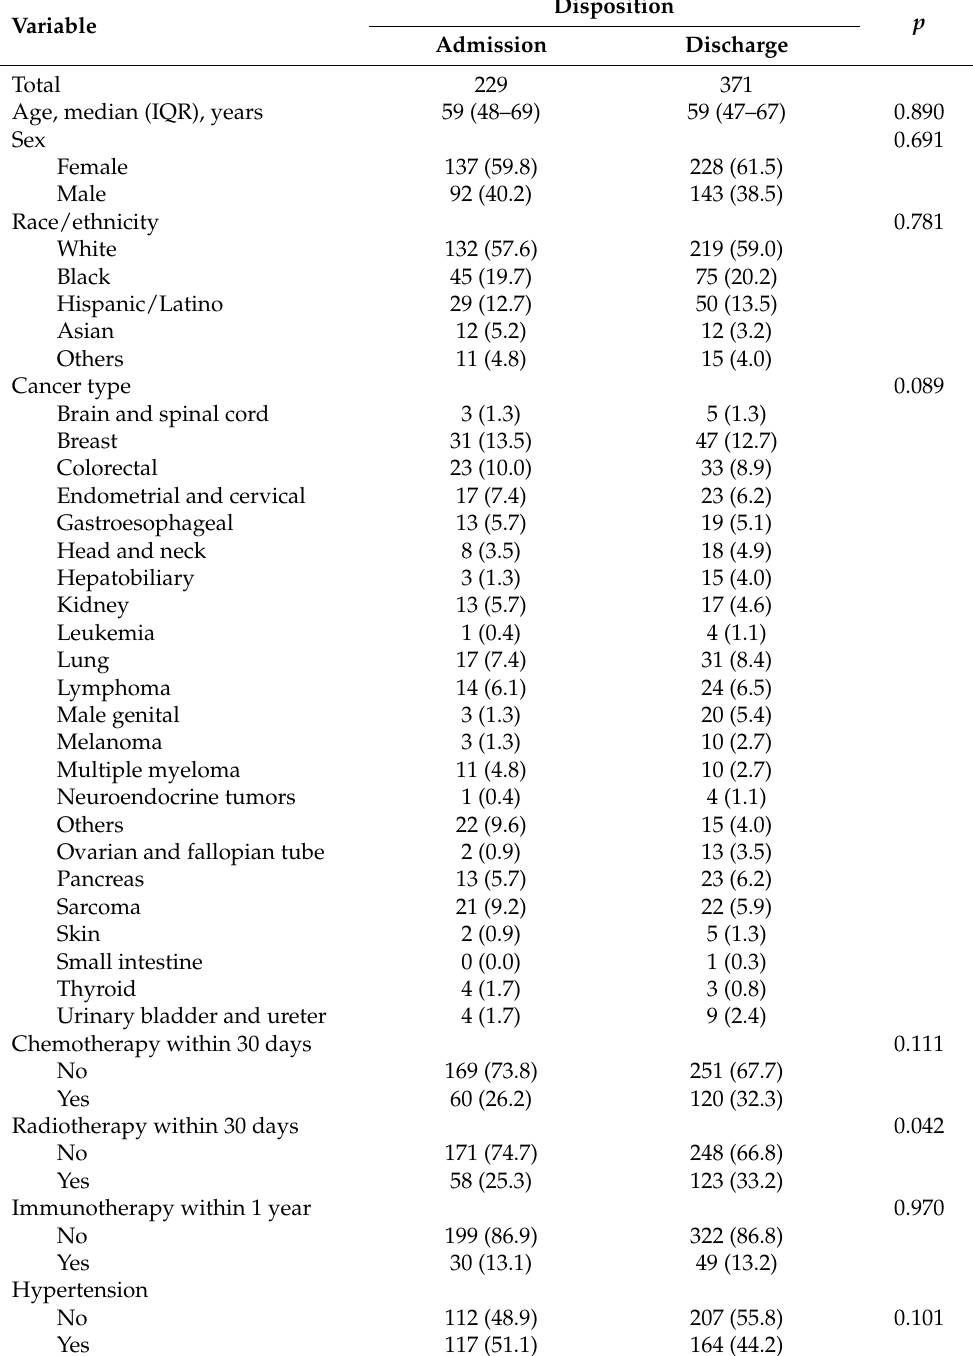
Table 4. Clinical characteristics and outcomes of patients who were admitted to the emergency department observation unit for pain stratified by